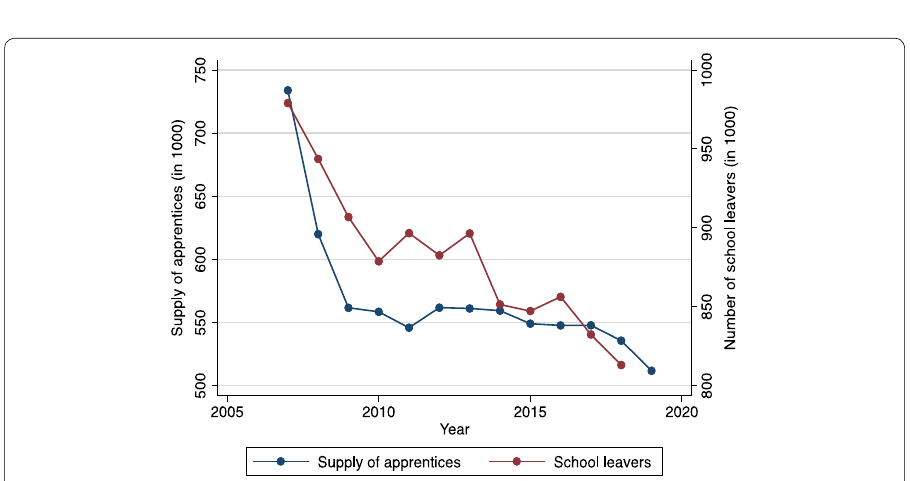
Fig. 3 Supply of apprentices and number of school leavers (2007–2019). Source: Federal Employment Agency (statistics on the apprenticeship market), Federal Statistical Office (school leavers from general schools, excluding vocational